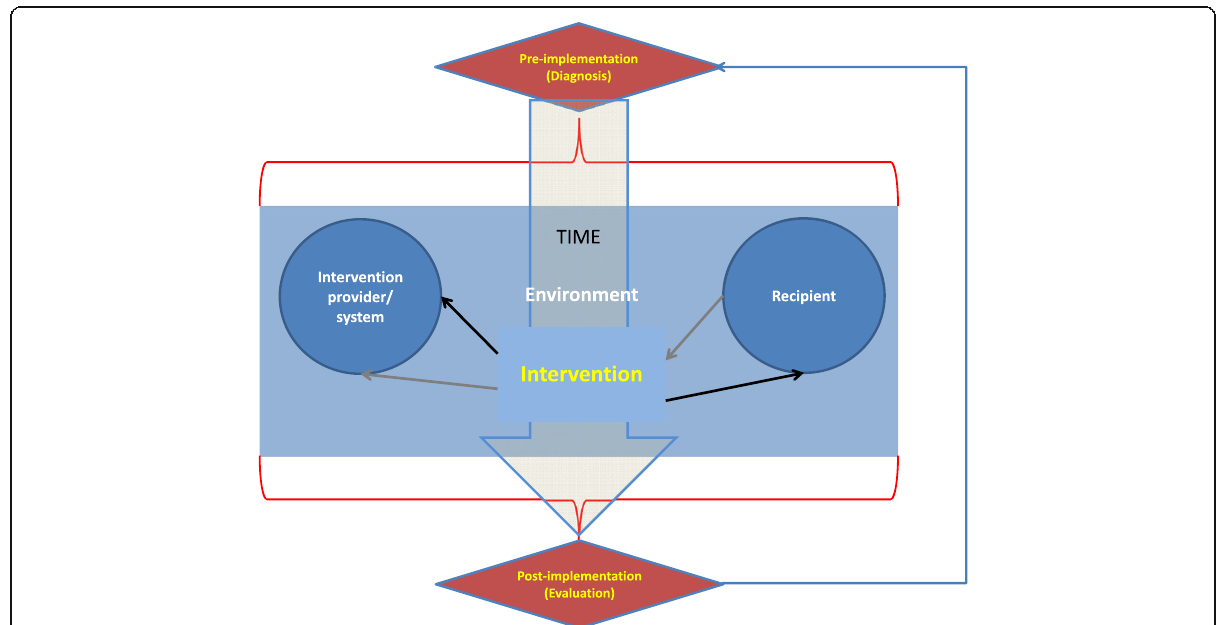
Fig. 3 A synthesis of implementation science frameworks. Source: Authors